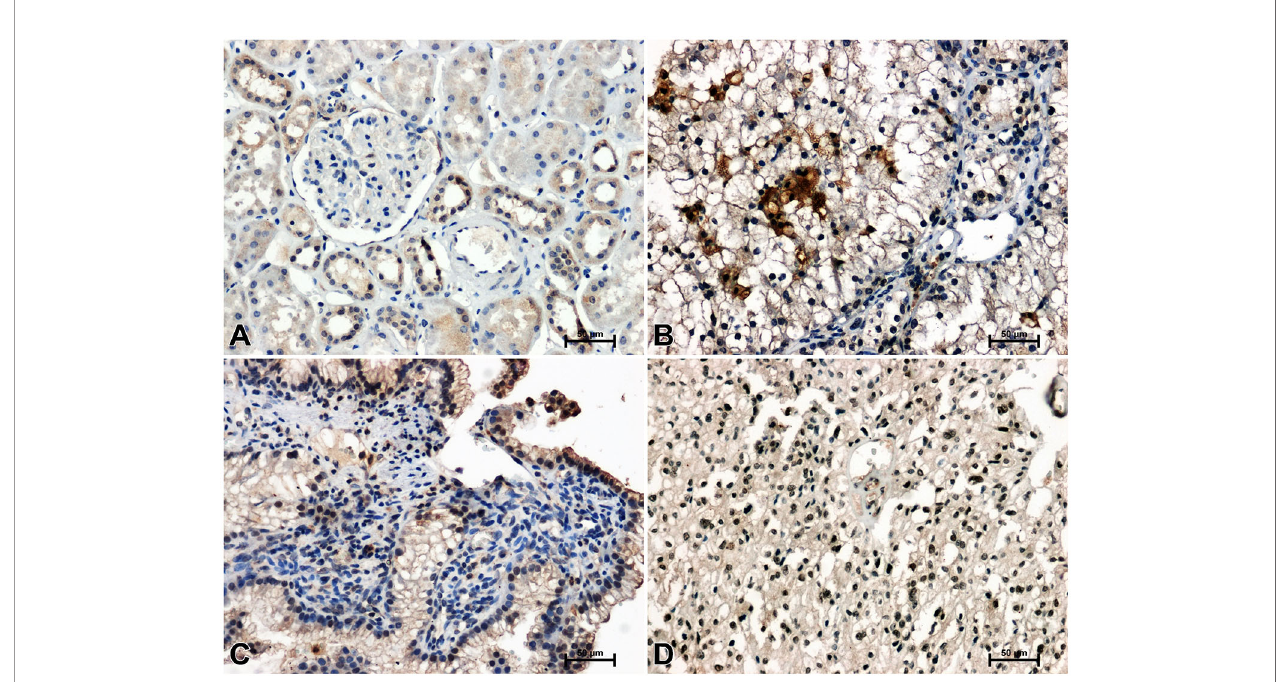
FIGURE 1 | Immunoidenti fi cation of WNT10A in non-malignant kidney (A) and clear cell RCC (B) , papillary RCC (C) , chromophobe RCC (D) .